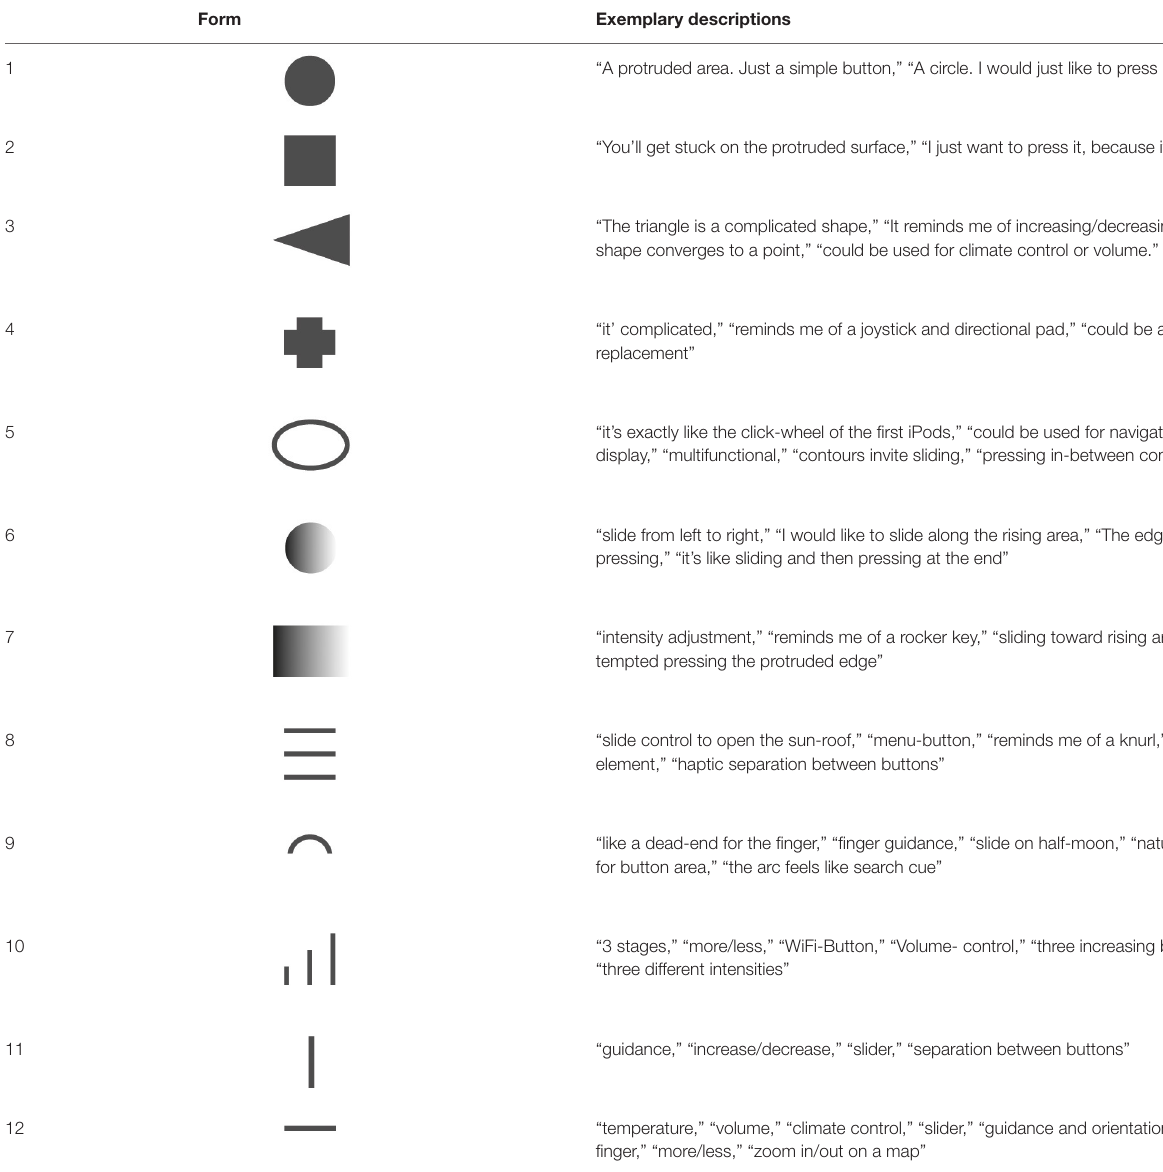
TABLE 3 | Exemplary verbal descriptions by the participants in the Association Study. Form Exemplary